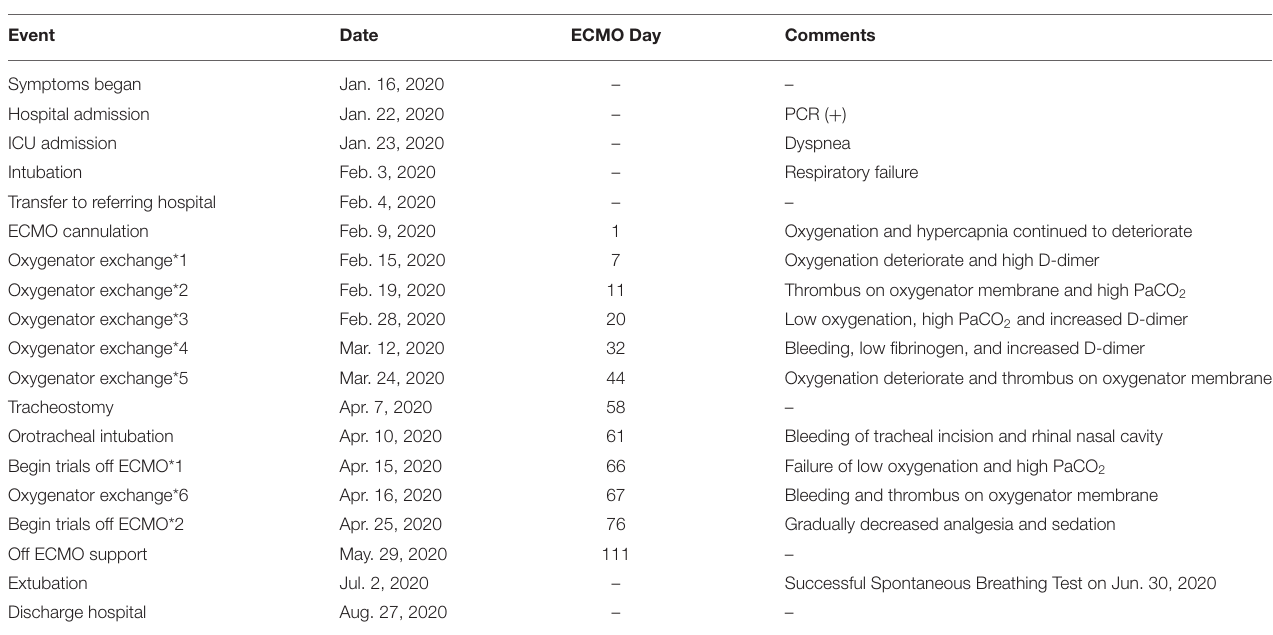
TABLE 1 | Timeline of medical and ECMO events in a patient with COVID-19. Event Date ECMO